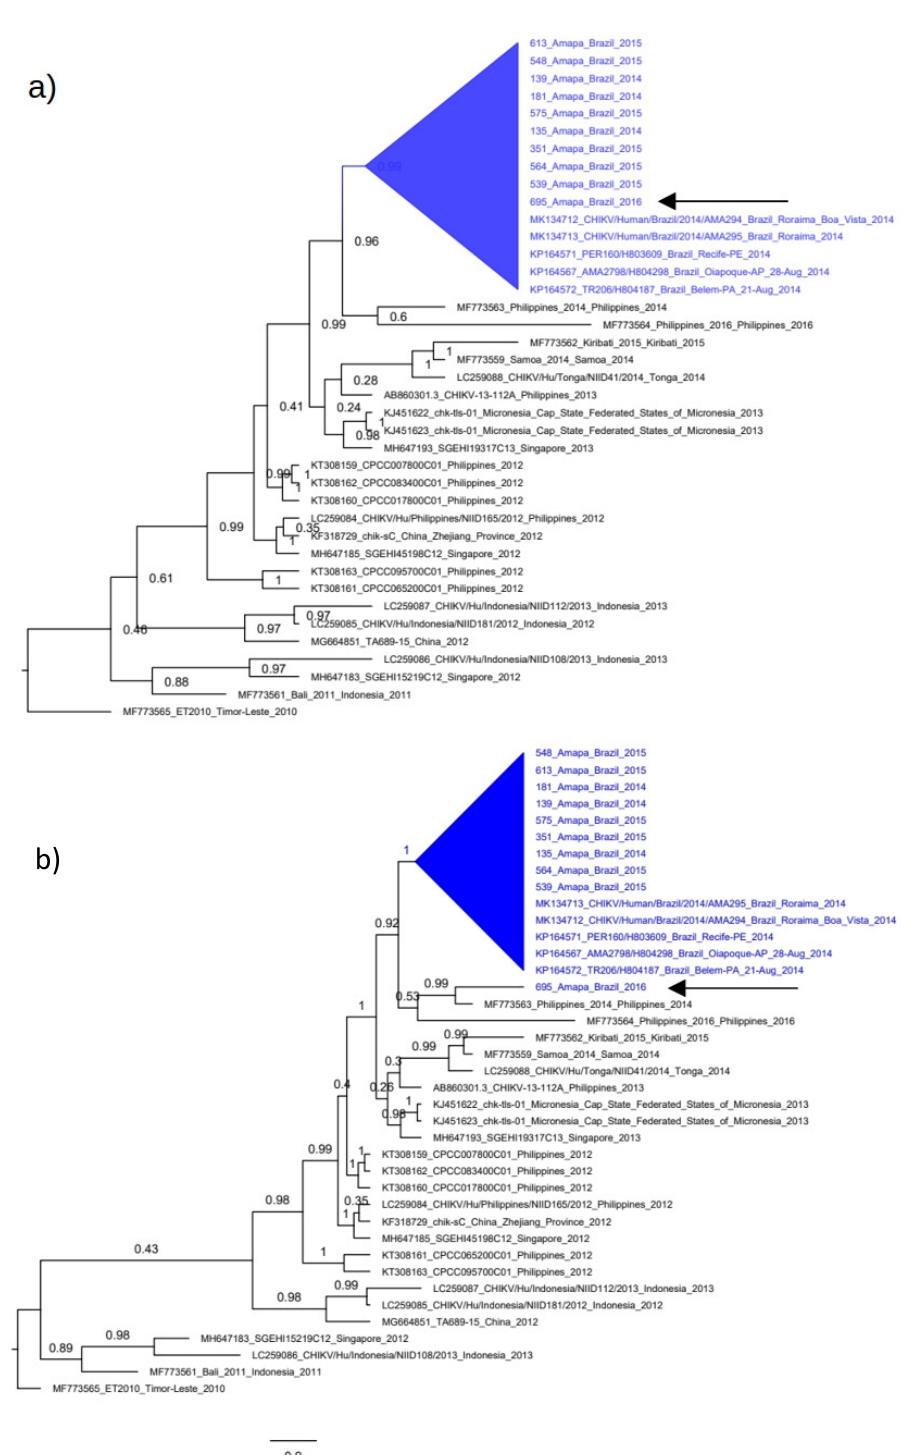
Figure 4. Monophyletic versus polyphyletic tree of CHIKV-Asian in Amapá. The coalescent trees were constructed using the complete genome of Brazilian CHIKV plus South Asian/Oceania references. The Bayesian approach was used and trees were constructed assuming the constant coalescent model plus the TN-93 evolutionary nucleotide model. The horizontal scale bar indicates nucleotide substitutions per site. Monophyletic clades are shown in the blue triangles in both trees. ( a ) Coalescent tree constructed assuming that the sequence 695_Amapa (indicated by arrow) is monophyletic. ( b ) Coalescent tree constructed assuming that the sequence 695_Amapa (indicated by arrow) is not within the monophyletic formed by the Brazilian sequences.